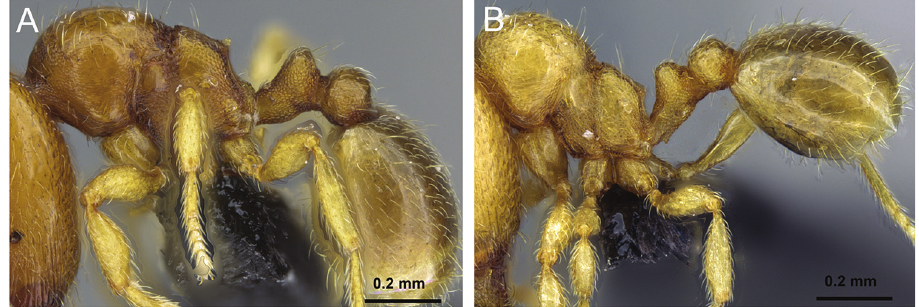
Figure 10. Petiole and postpetiole in profile view of A Carebara omasi (CASENT0028862) B Carebara nosindambo (CASENT0073096).